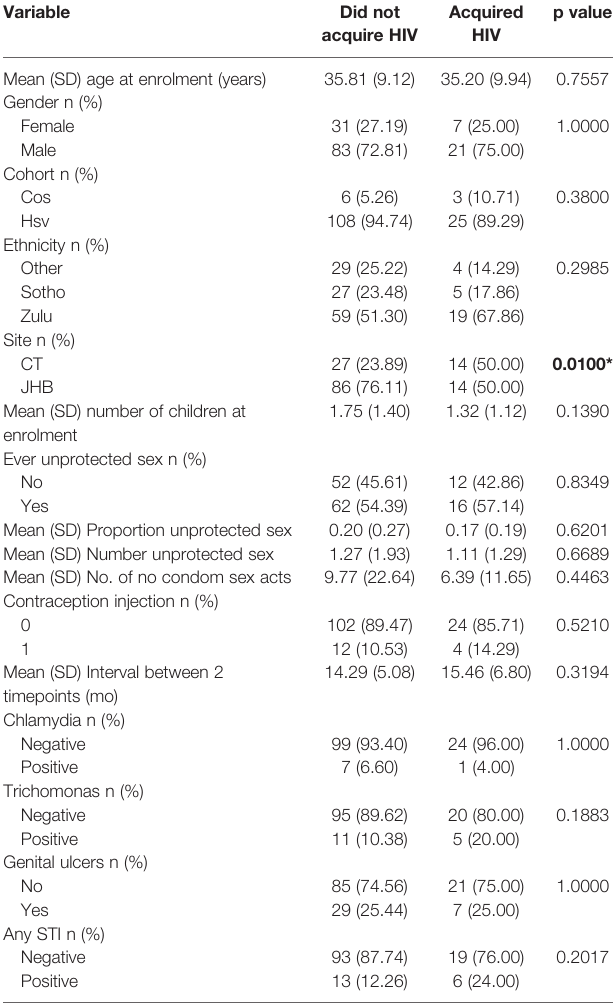
TABLE 5 | Characteristics of individuals who were HIV-uninfected at enrolment (n=115 highly exposed persistently seronegative controls and 28 HIV-